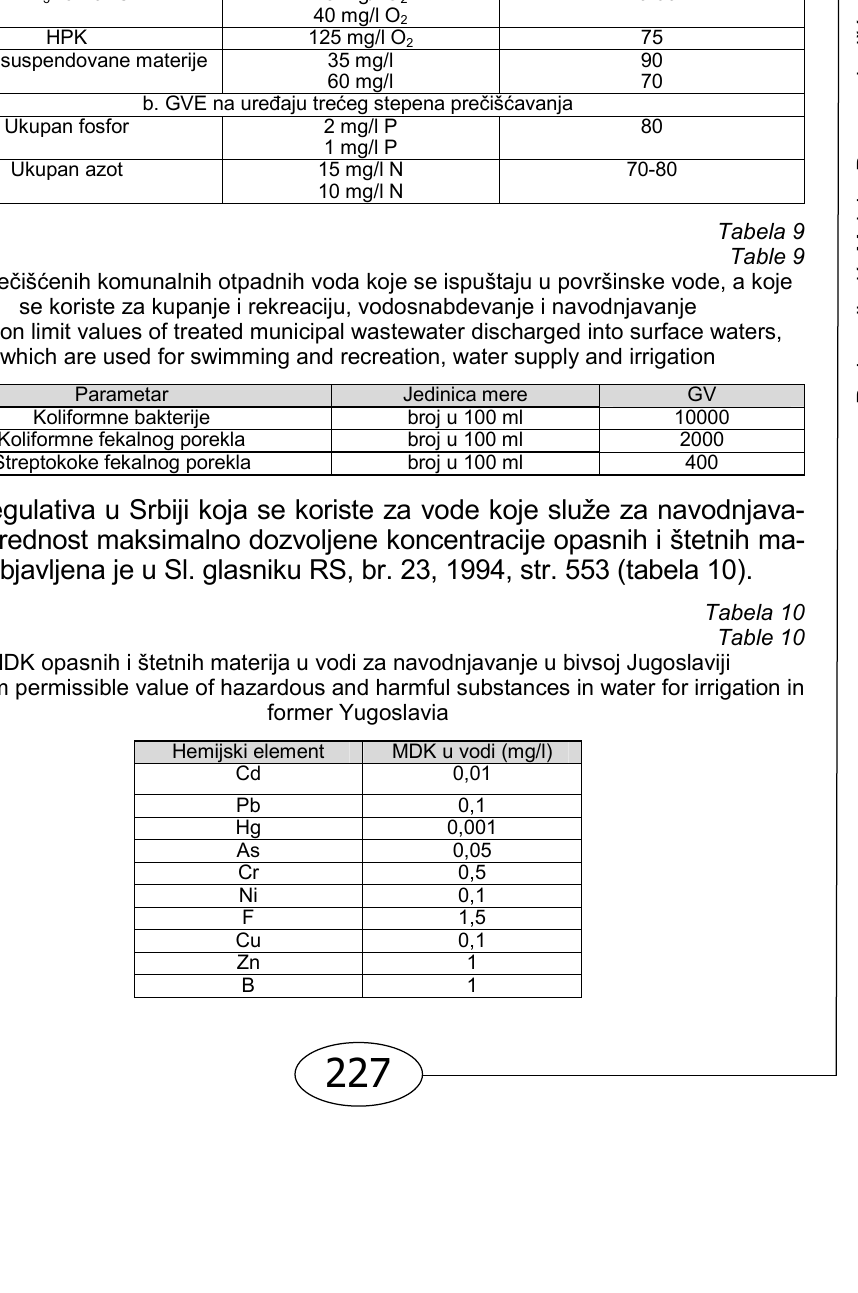
Grani č na vrednost emisije za komunalne otpadne vode koje se ispuštaju u površinske vode Emission limits for municipal wastewater discharged into surface waters